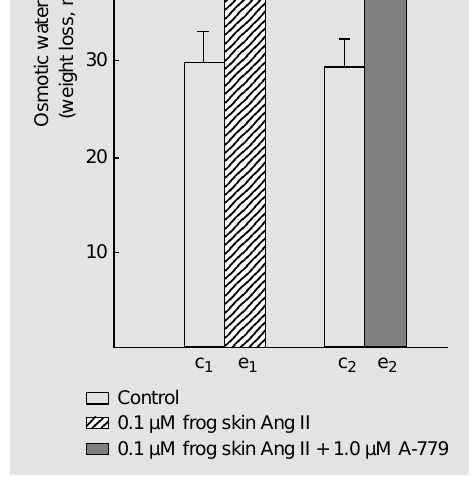
Figure 5 - Lack of effect of the specific Ang-(1-7) antagonist (A- 779) on osmotic water perme- ability stimulated with frog skin Ang II. Data are reported as means ± SEM. One-way ANOVA followed by the Newman-Keuls test showed no significant dif- ferences (N.S.) between e 1 and e 2 or c 1 and c 2 .